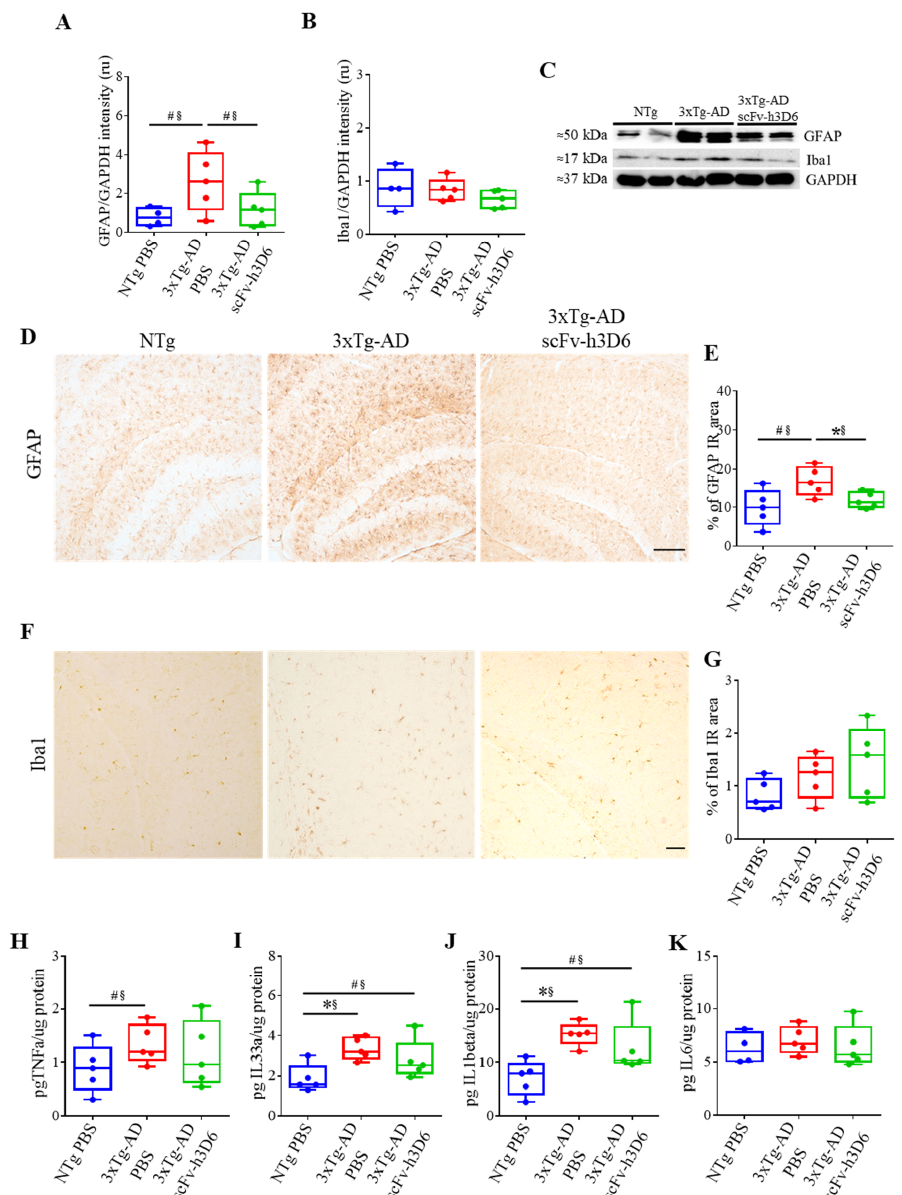
Figure 6. ScFv-h3D6 does not elicit any detectable neuroinflammatory response in the hippocampus. ( A ) GFAP levels are measured by Western blotting and normalized by GAPDH levels. Intensity is expressed in relative units. ( B ) Iba1 levels measured by Western blotting and normalized by GAPDH levels. Intensity is expressed in relative units. ( C ) Representative Western blot image of GFAP and Iba1 in NTg, 3xTg-AD PBS, and 3xTg-AD scFv-h3D6 treated mice. ( D ) GFAP labeling in untreated NTg (left), untreated 3xTg-AD (center), and scFv-h3D6-treated 3xTg-AD (right) mice. Scale bar, 100 µm. ( E ) Percentage of GFAP-immunoreactive area. ( F ) Iba1 labeling in untreated NTg (left), untreated 3xTg-AD PBS (center), and scFv-h3D6-treated 3xTg-AD (right) mice. Scale bar, 25 µm. ( G ) Percentage of Iba1-immunoreactive area. ( H – K ) Interleukin levels as measured by ELISA (in picograms) and normalized by the total amount of protein as quantified by the BCA assay (in micrograms) in the TBS-soluble fraction. ( F ) TNF- α levels. ( G ) IL-33 levels. ( H ) IL-1 β levels. ( I ) IL-6 levels. Three replicates for each experiment. Data are expressed as medians in box plots, and whiskers represent the minimum and maximum values. Statistical di ff erences were assessed with the non-parametrical test U Mann-Whitney. * Significant di ff erences p ≤ 0.05; # Marginal significance p ≤ 0.1; § r ≥